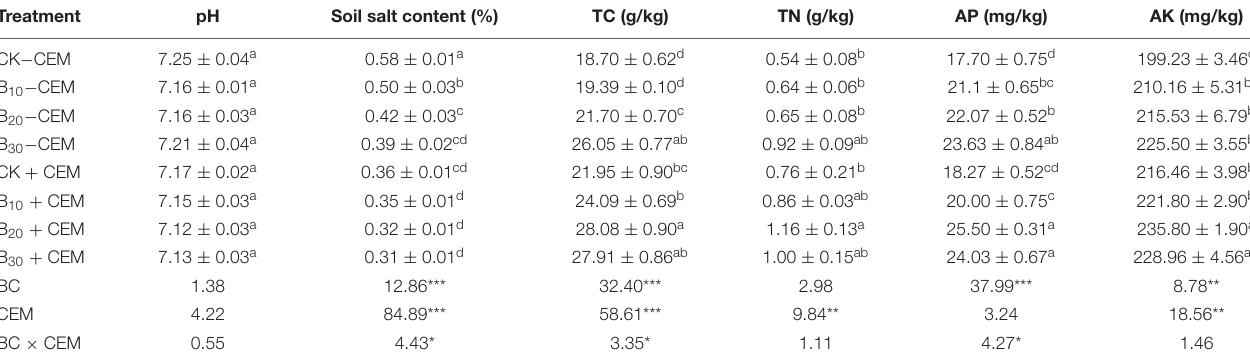
TABLE 1 | Soil properties and fertility under different treatments.